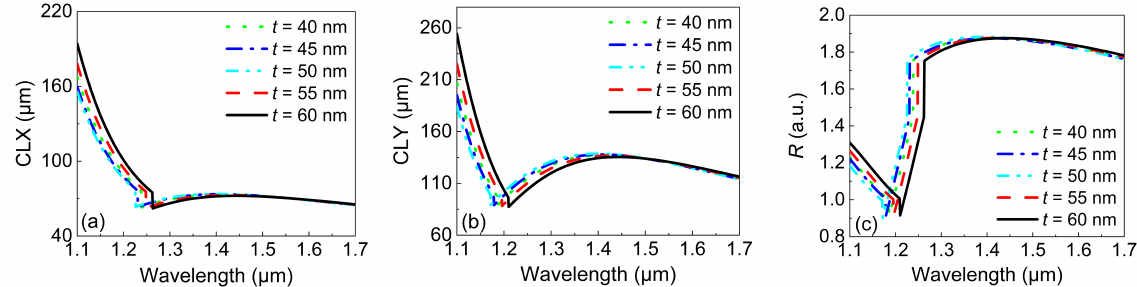
Figure 8. The variations in ( a ) the CLX and ( b ) CLY with the wavelength under different values of t . ( c ) The variations in R with the wavelength under different values of t .